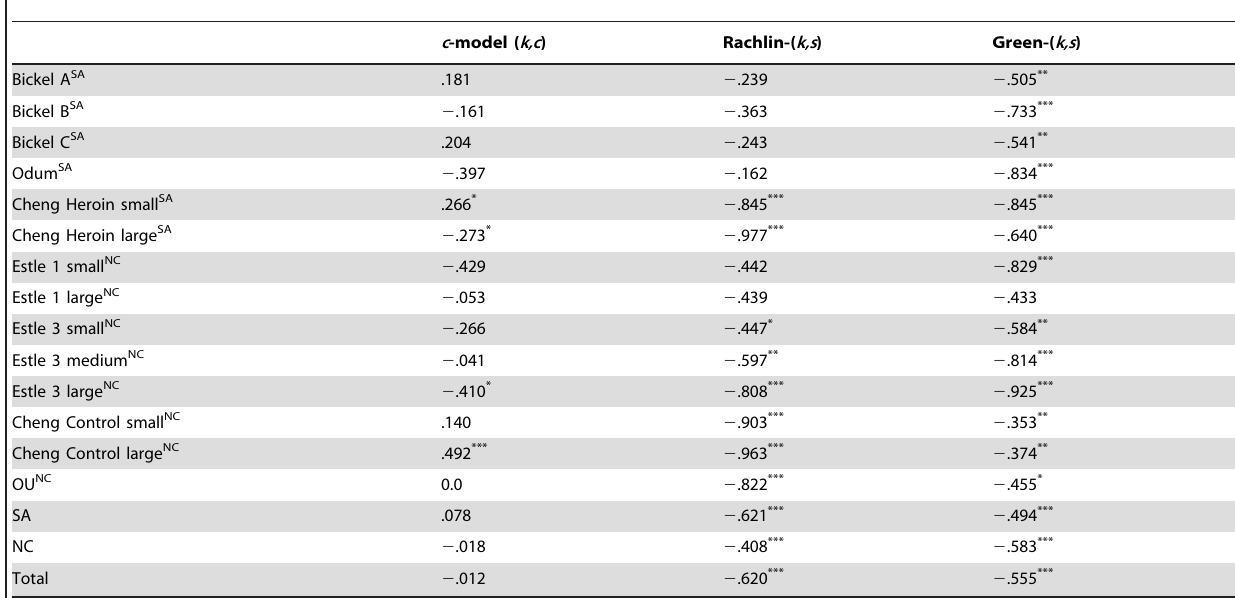
Table 8. Spearman Rank Correlations Between the Model Parameters.